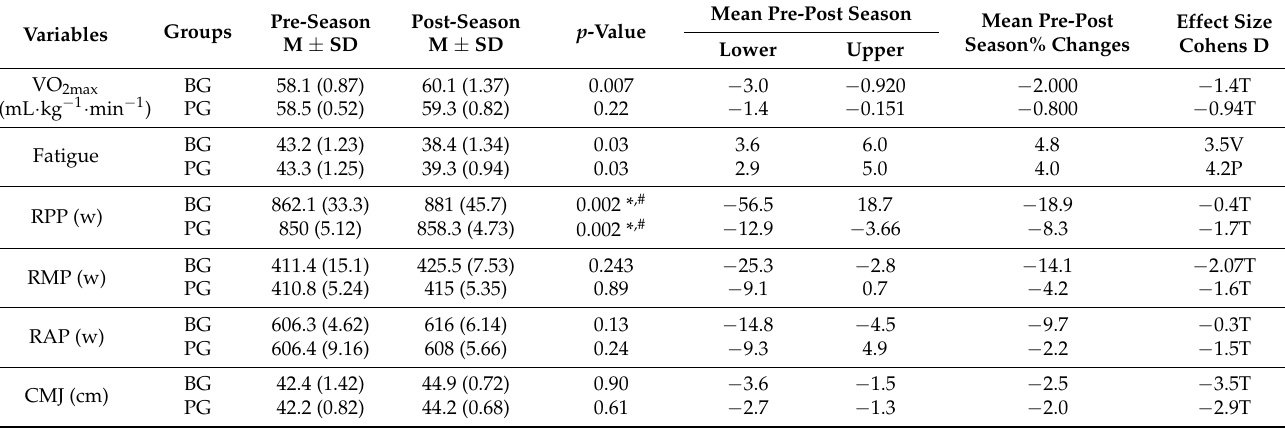
Table 3. Changes of bio-motor abilities during pre- mid- and